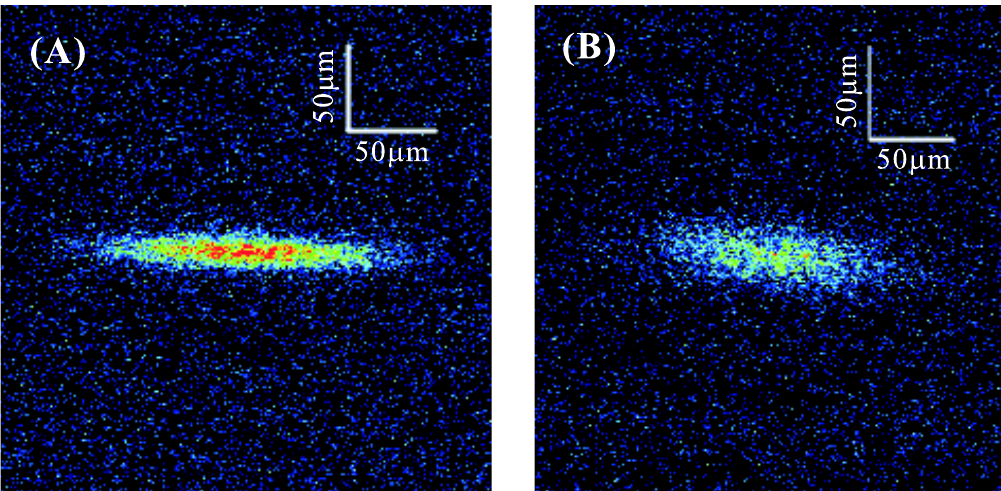
FIG. 20. (Color) Measured beam profiles when the skew correction was carefully carried out (A) and all of the skew magnets were turned off (B). The data were taken on 2005 = 6 = 1 with a 4.4 mA